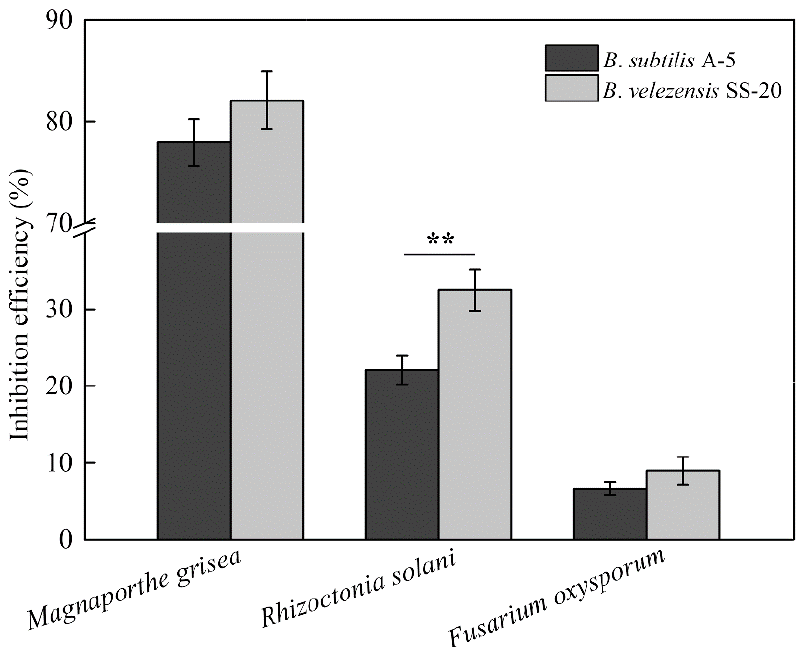
Figure 1. Analysis of the antagonistic efficiency of B. subtilis A-5 against fungal plant pathogens. “**” indicates statistically significant difference at the 0.01 level ( p < 0.01). 3.3. Analysis of the Salinity and Alkalinity Tolerance of B. subtilis A-5 Compared to the positive strain ( B. velezensis SS-20) and negative strain ( B. subtilis FD4-1), B. subtilis A-5 conferred a high-level tolerance to salinity and alkalinity. Strain A-5 exhibited stress resistance under 12% NaCl or pH 10.5 condition, but the OD 600 was